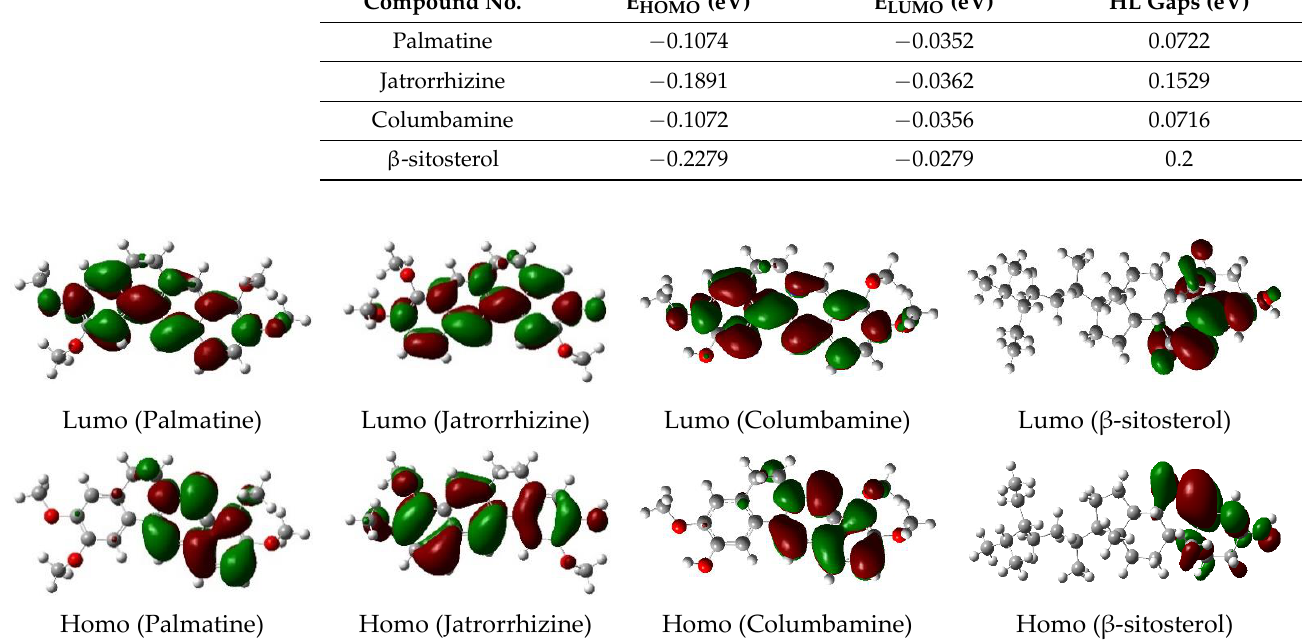
Table 5. LUMO and HOMO energies and HOMO–LUMO (HL) gaps (in eV) of isolated compounds. Compound No.